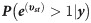
Posterior probabilities for the joint spatio-temporal interaction Peυst>1|y.